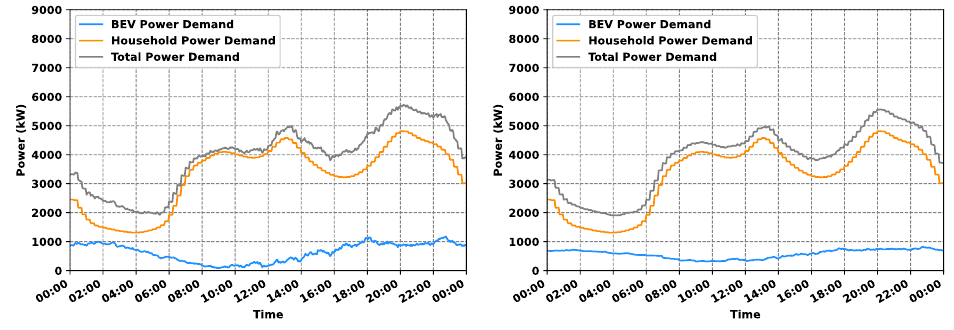
Figure 14. Temporal distribution of the BEV charging power demand for the LOR